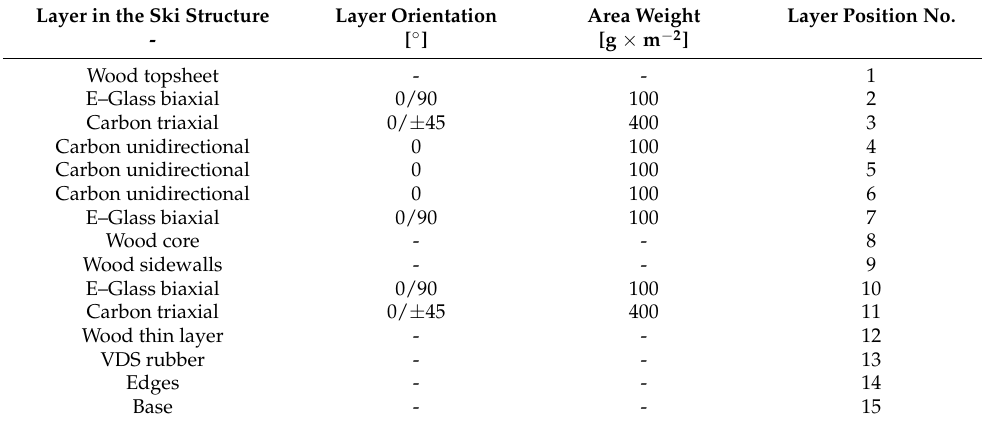
Table 2. Composition of materials in the ski